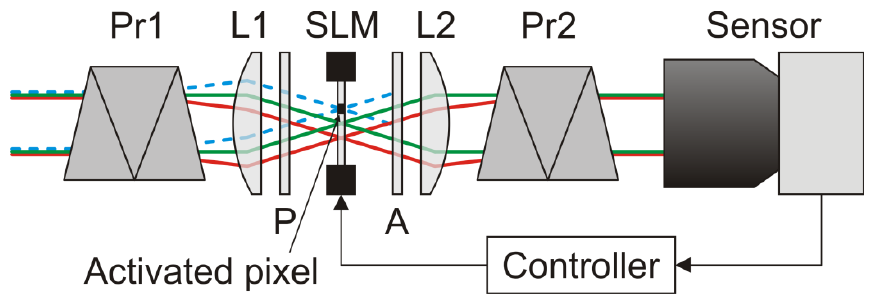
Figure 2. Sensor protection concept using wavelength multiplexing by means of two direct vision prisms (Pr1/Pr2: direct vision prisms; L1/L2: lenses; SLM: spatial light modulator; P/A: polarizers). Due to the spectral dispersion, the activation of the single SLM elements attenuates only a narrow spectral band (blue dashed rays) of the incident light beam, whereas all remaining wavelengths from the incident beam can pass through the optical arrangement unaffected (red and green rays). This setup allows for combined spatial and spectral filtering of monochromatic light sources whatever the